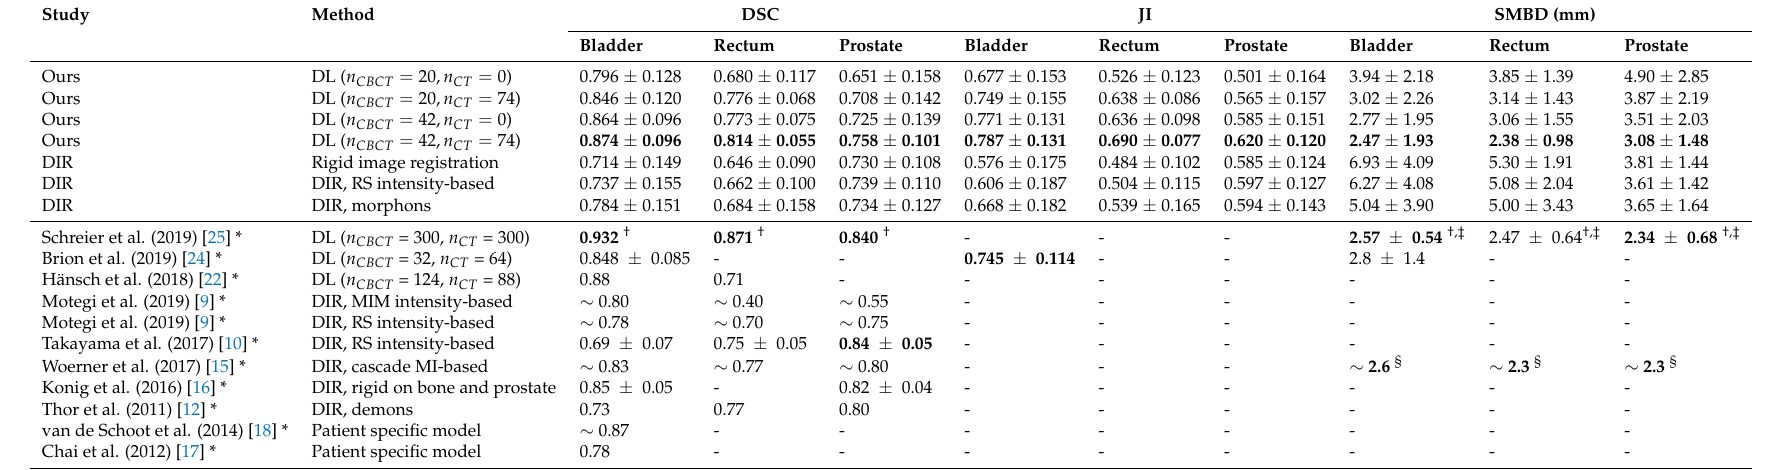
Table 2. DSC, JI, and SMBD, between the manual contours and the output of our proposed algorithm in different settings (number of training CBCT scans, number of training CT scans) for bladder, rectum, and prostate. Comparison with other benchmarking algorithms. Best results are presented in bold for our simulations and the state-of-the-art. DL: deep-learning, RS: RayStation, DSC: Dice similarity coefficient, JI: Jaccard index, SMBD: symmetric mean boundary distance, DIR: deformable image registration, PSM: patient specific model. * Evaluated on a dataset different from ours. † Results reported on a test set containing both CBCT and CT scans. ‡ The authors computed the root mean squared boundary distance rather than the SMBD. § The authors computed the mean boundary distance and not the